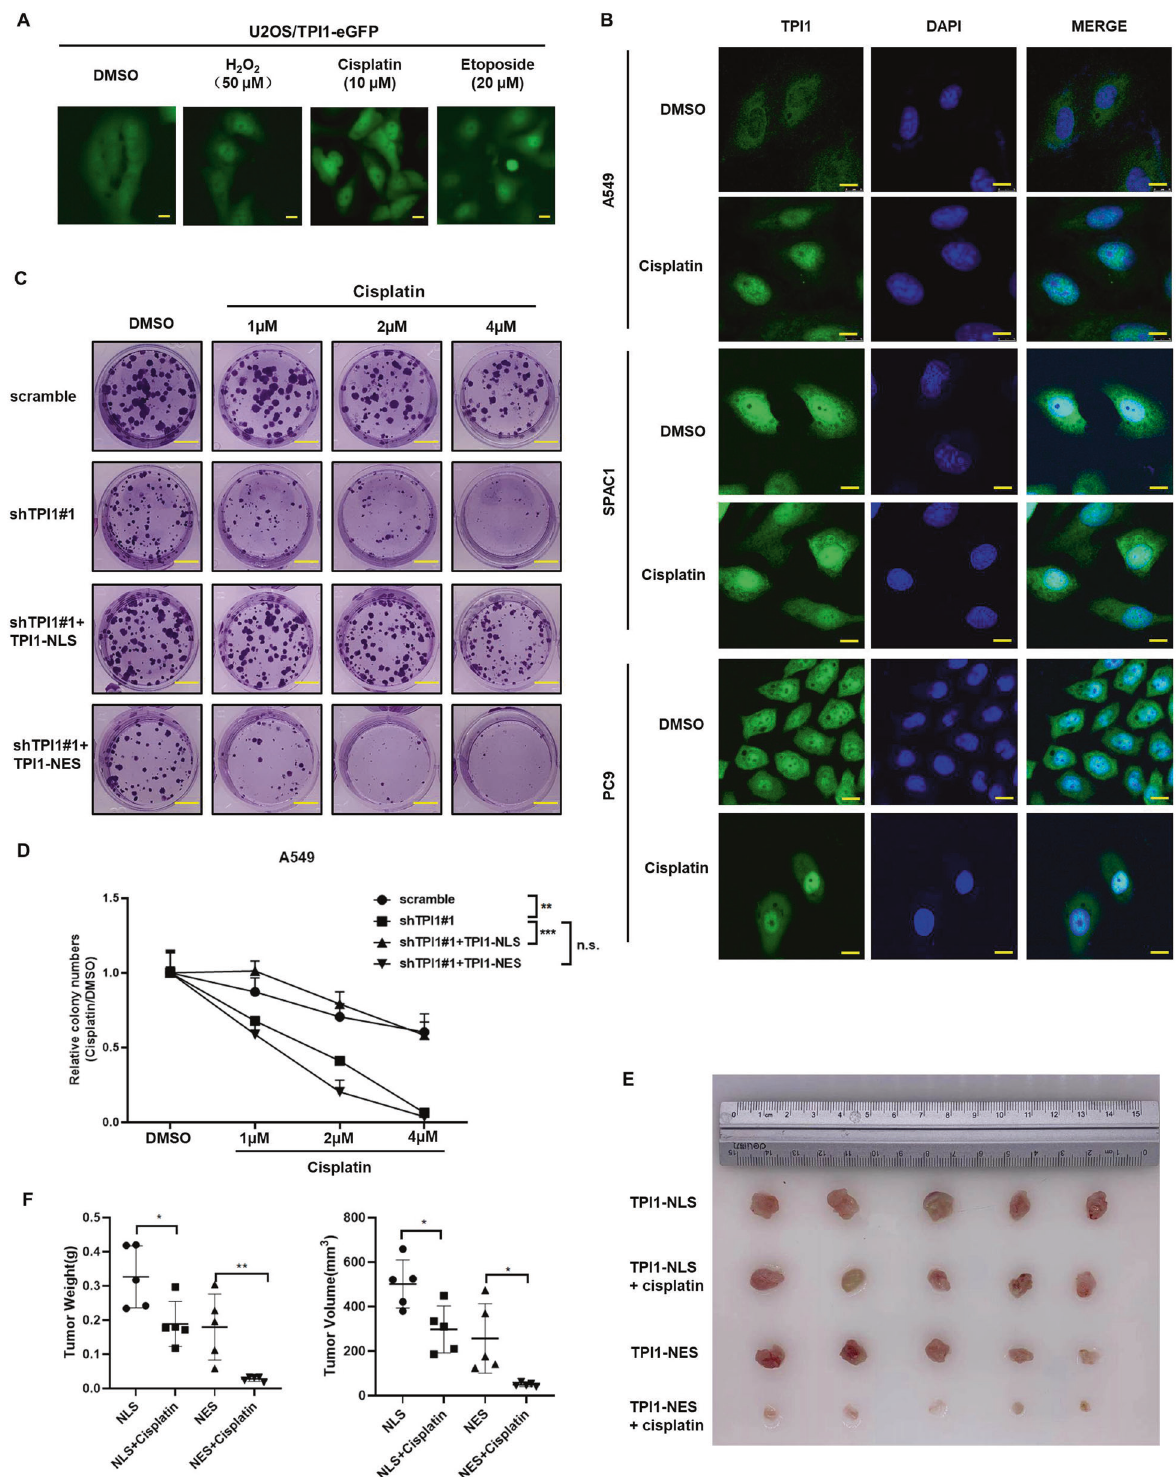
Fig. 6 TPI1 nuclear translocation is induced by oxidative stress and chemotherapy drugs, confers resistance to chemotherapy. A Translocation of TPI1-GFP upon treatment with H 2 O 2 , cisplatin, or etoposide in U2OS cells. B Translocation of endogenous TPI1 in response to cisplatin or etoposide treatment in A549, SPAC1, and PC9 cells. C Colony formation upon cisplatin treatment in Scramble, TPI1 knockdown, TPI1-NLS or TPI1-NES expressing cells. D Quanti fi cation of colony formation results in ( C ). Asterisks denote statistical signi fi cance with one-way ANOVA. ** p < 0.01; *** p < 0.001 for the indicated comparison. E Xenograft tumors from TPI1-NES A549 cells are more resistant to cisplatin treatment than those from TPI1-NLS cells. F Quanti fi cation of weight and volume of xenograft tumors. Values are mean tumor weight/volume ± SD of fi ve mice within each group. Asterisks denote statistical signi fi cance with one-way ANOVA. * p < 0.05; ** p < 0.01.